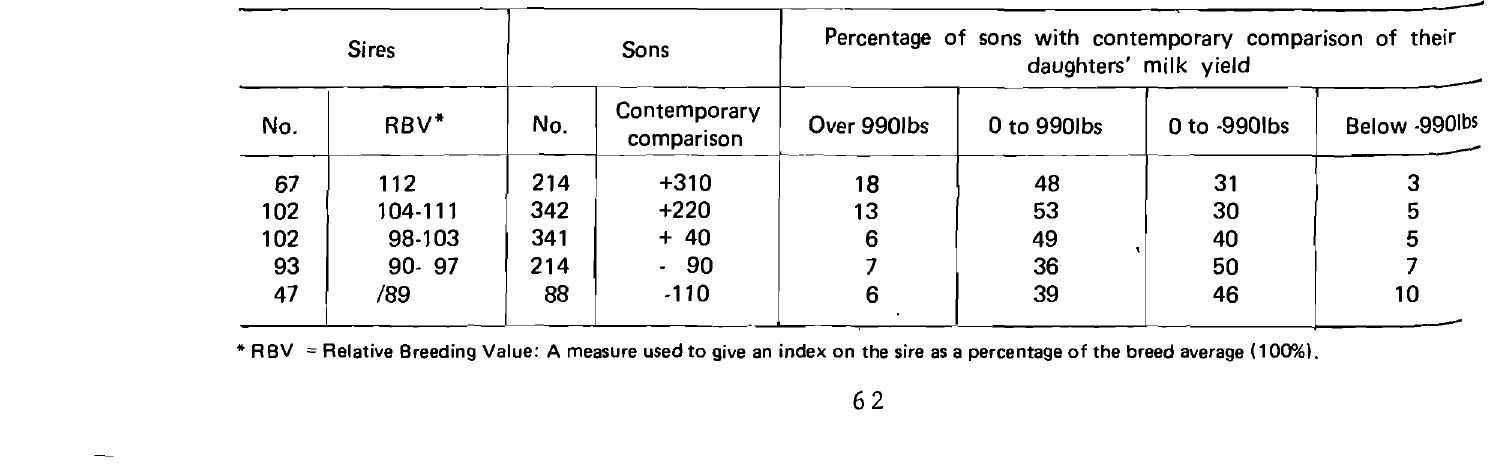
Table 5: COMPARISON OF SIRES AND SONS IN THE MILK MARKETING BOARD PROGENY TESTING